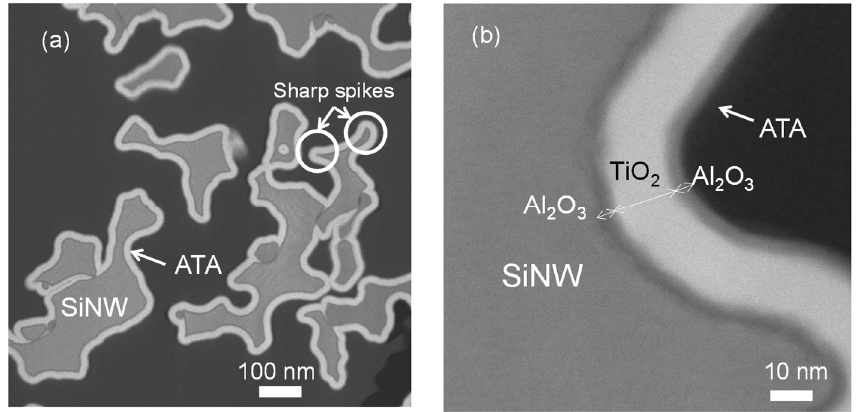
Figure 3. Round-sliced HAADF-STEM images of a SiNW array coated with ATA, ( a ) × 160,000, ( b ) × 1,600,000. Each thickness of ATA was Al 2 O 3 (3.6 nm)/TiO 2 (15.2 nm)/Al 2 O 3 (3.7 nm).